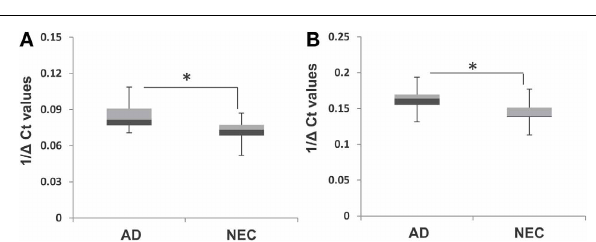
FIGURE 7 | Box plot representation of transcript levels of miR-34a and miR-34c in peripheral blood mononuclear cell (PBMC) samples from Alzheimer’s disease (AD) patients and normal elderly controls (NEC). Comparison of levels of miR-34c (A) and miR-34a (B) in AD patients with that of the NEC cohort in PBMCs, showing increased transcript levels for both microRNAs in the former group, compared to normal controls. Student’s t- test was used to determine statistical significance; ∗ P < 0 . 05.